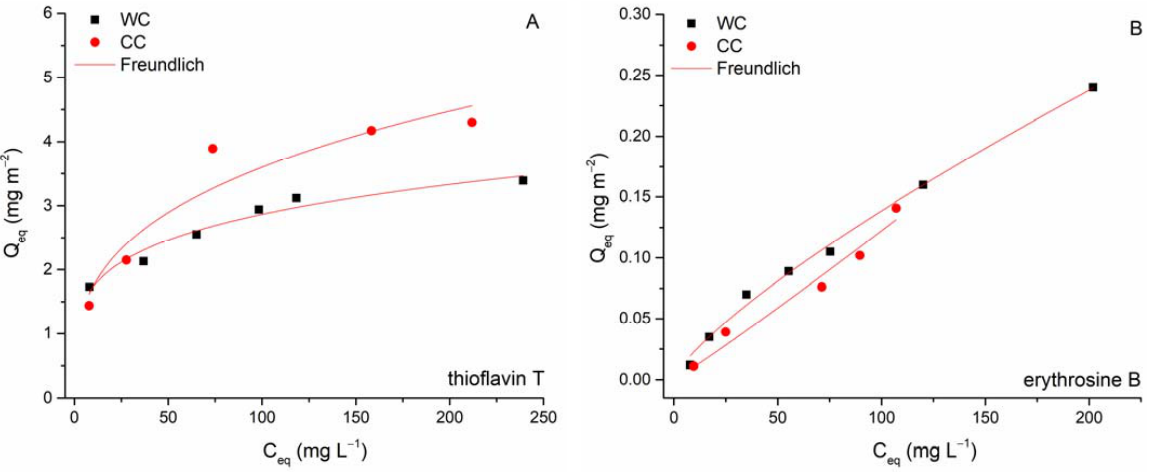
Figure 10. Surface ‐ area ‐ normalized adsorption isotherm for TT and EB on WC ( A ) and CC ( B ) biochars. ( B )